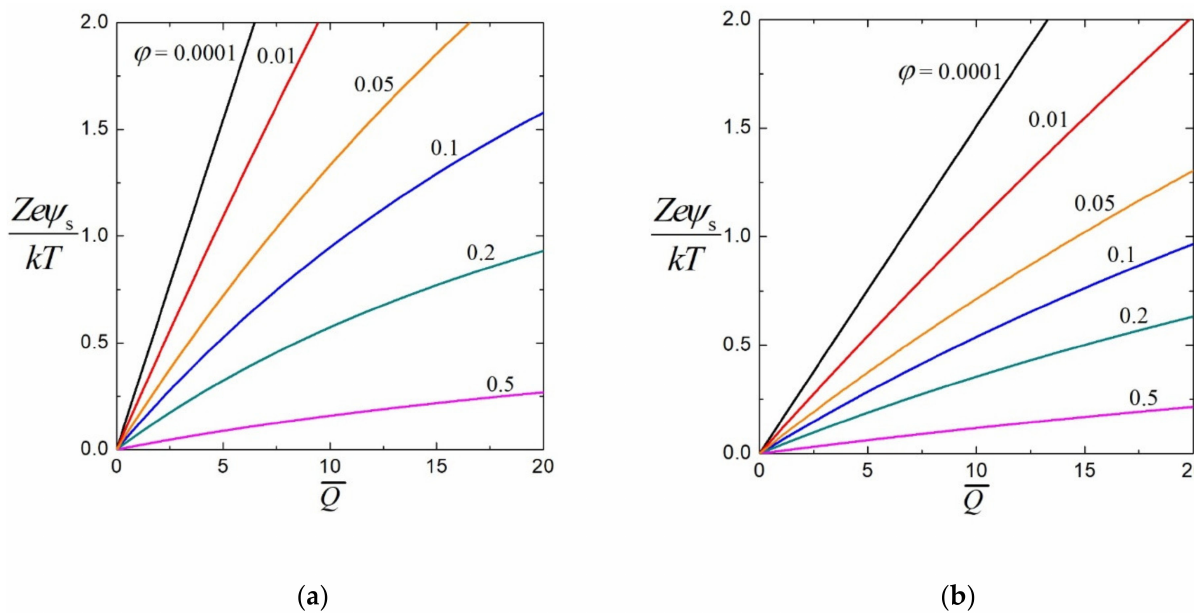
Figure 3. Dimensionless relative surface potential Ze ψ s / kT for a suspension of soft spheres versus Q with ϕ as a parameter: